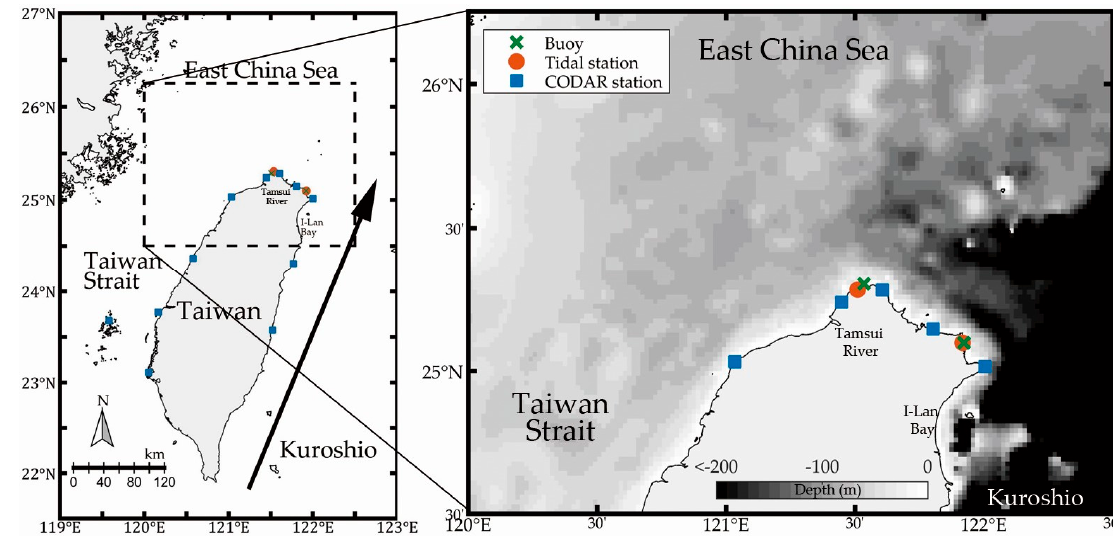
Figure 1. Study area (dotted frame) and adjacent region. The red dot is the tidal station, the green cross is buoy, the blue square is the coastal ocean dynamics applications radar (CODAR) station, and the black arrow is the Kuroshio main path. The background color of the enlarged study area is the submarine topography obtained from the ETOPO1 1 arc-minute global relief model (doi:10.7289/V5C8276M).